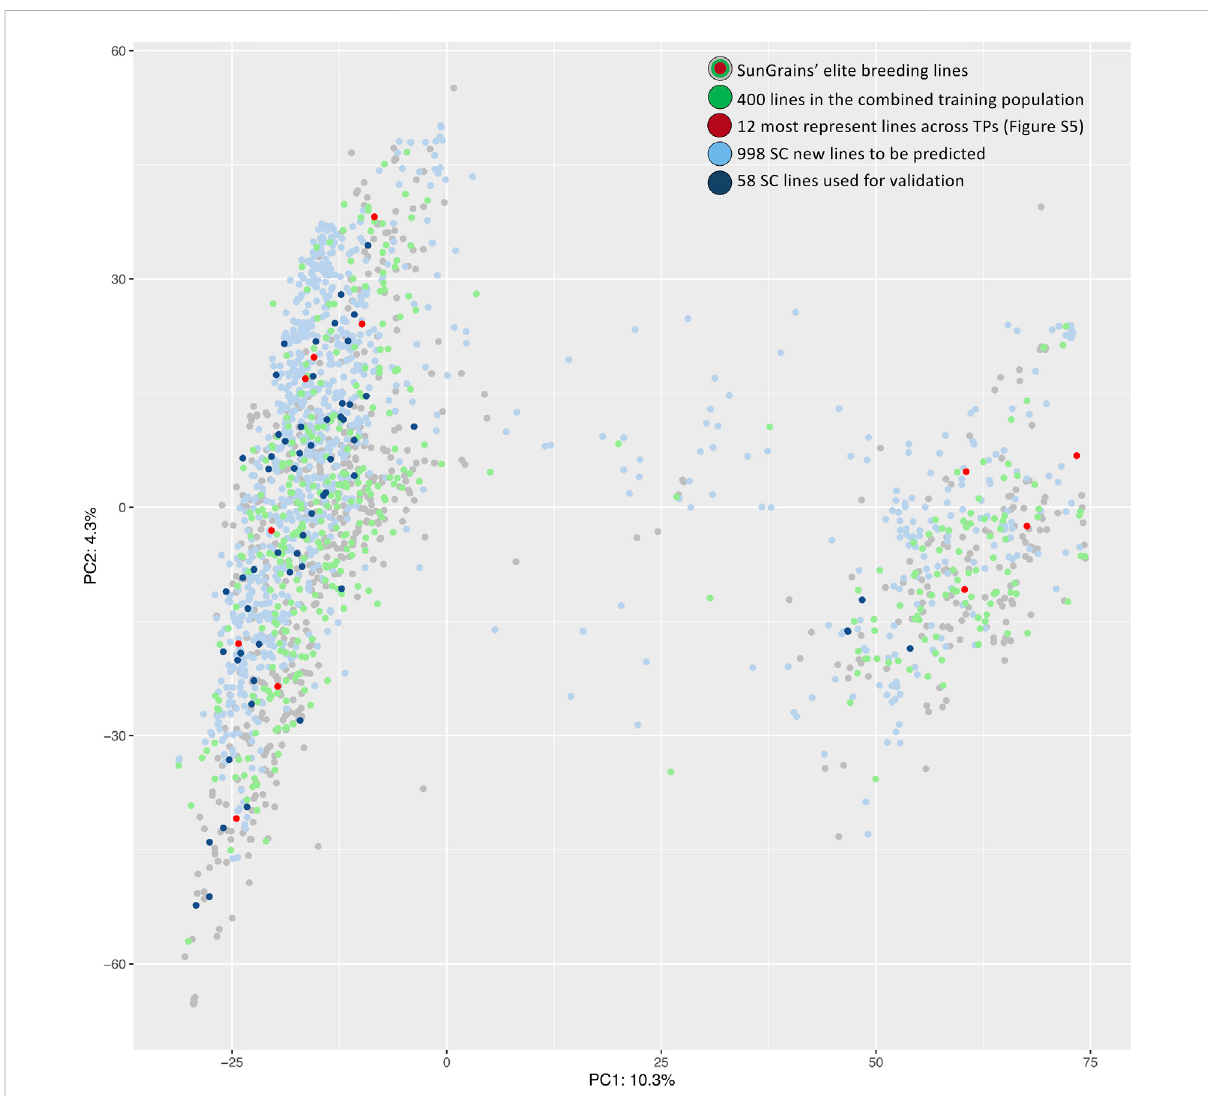
FIGURE 2 PCA plot of fi rst two principal components is showing the genetic relationship between SunGrains ’ elite lines (gray, green and red dots), the SC new breeding lines (light blue) and SC lines used for validation (dark blue). Lines selected in the combined TP (SetAll_TP) are indicated in green and lines present in at least 20 TPs (Supplementary Figure S5) are highlighted in red. Percentage represent the proportion of variance explained by each principal